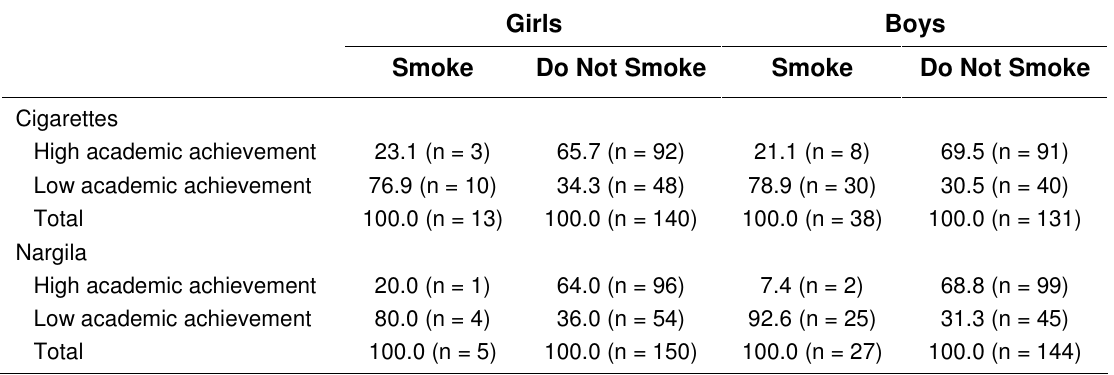
Odds Ratio of Nargila and Cigarette Use (Predicting Variables): Logistic Regression Data